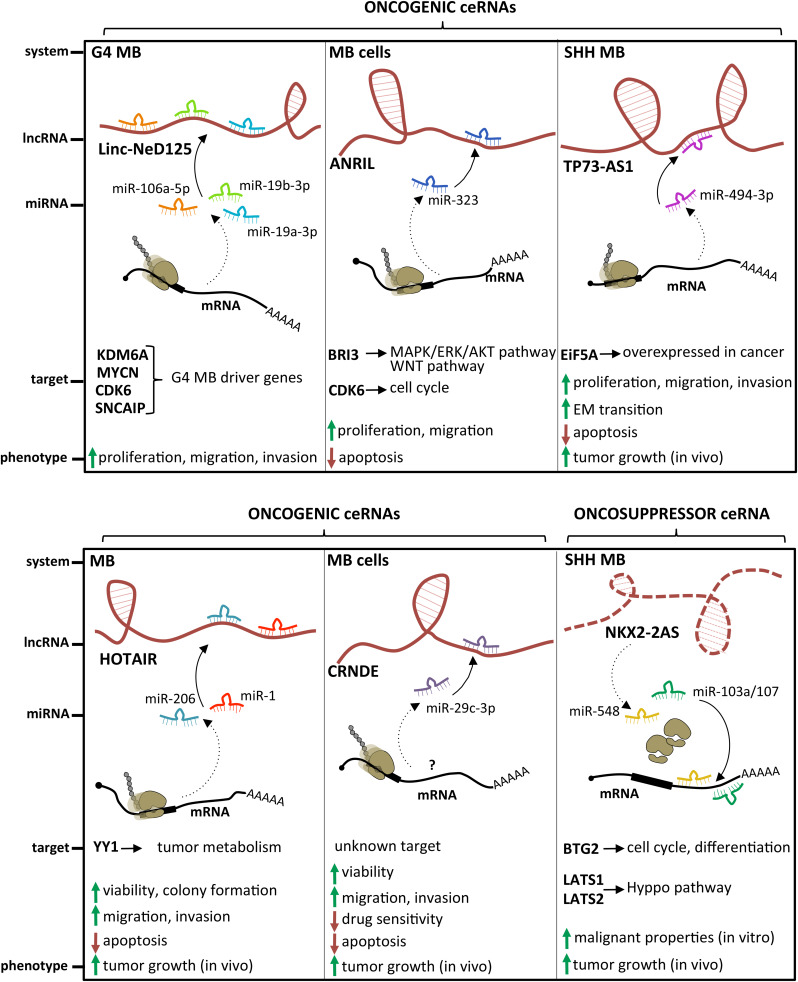
State of the art on lncRNAs functioning as oncogenes or oncosuppressors through their competing endogenous RNA (ceRNA) activity. A handful of lncRNAs, such as Linc-NeD125, ANRIL, TP73-AS1, HOTAIR, and CRNDE, may function as oncogenes by sponging specific miRNAs and leading to derepression of their target genes. Differently, only NKX2-2AS has been described as a lncRNA endowed with oncosuppressor activity.